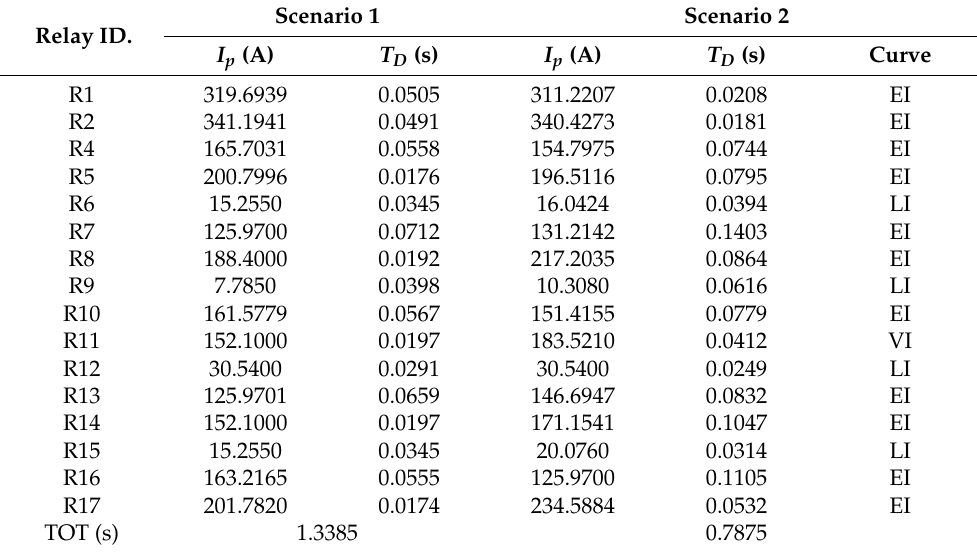
Table 9. OCRs optimum settings of Agiba network using Test Model 3.